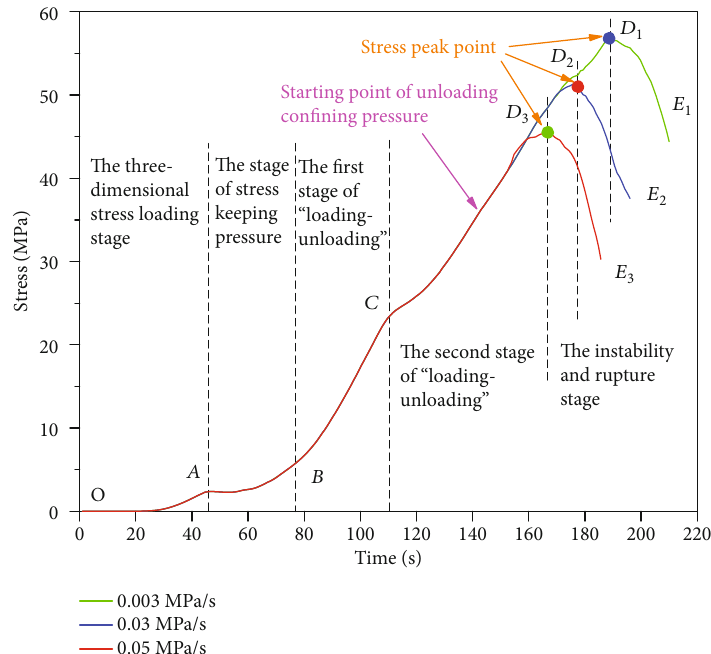
Figure 3: Stress-time curves at di ff erent pressure unloading rates. Under the con fi ning pressure of 10MPa and the unloading rates of 0.003MPa/s, 0.03MPa/s, and 0.05MPa/s, the comparison of stress stages in the process of triaxial loading-unloading of composite coal- rock was made. Here, D 1 , D 2 , and D 3 are the stress peak points under the unloading con fi ning pressure rate of 0.003MPa/s, 0.03MPa/s, and 0.05MPa/s, respectively.